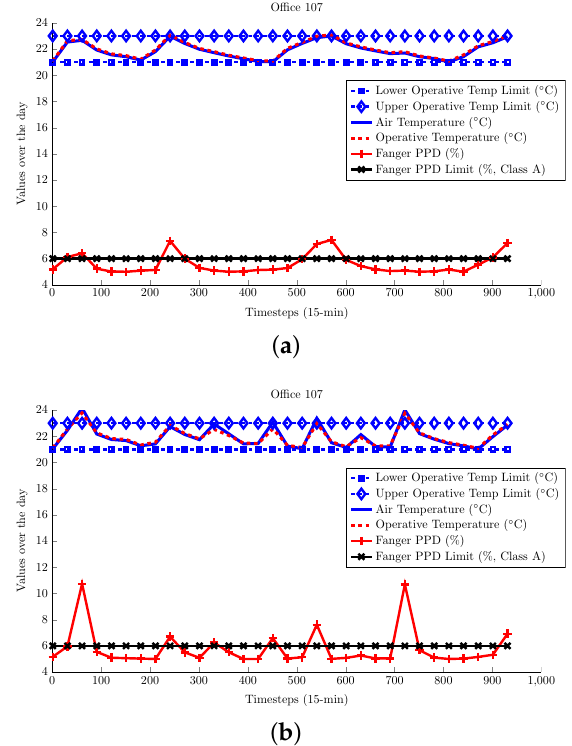
Figure 16. Results for Office 107 of the ZUB building: ( a ) Results for Office 107 using the air temperature thermostat set at 22 ◦ C, blinds always closed and no internal gains; and ( b ) results for Office 107 using the air temperature thermostat set at 22 ◦